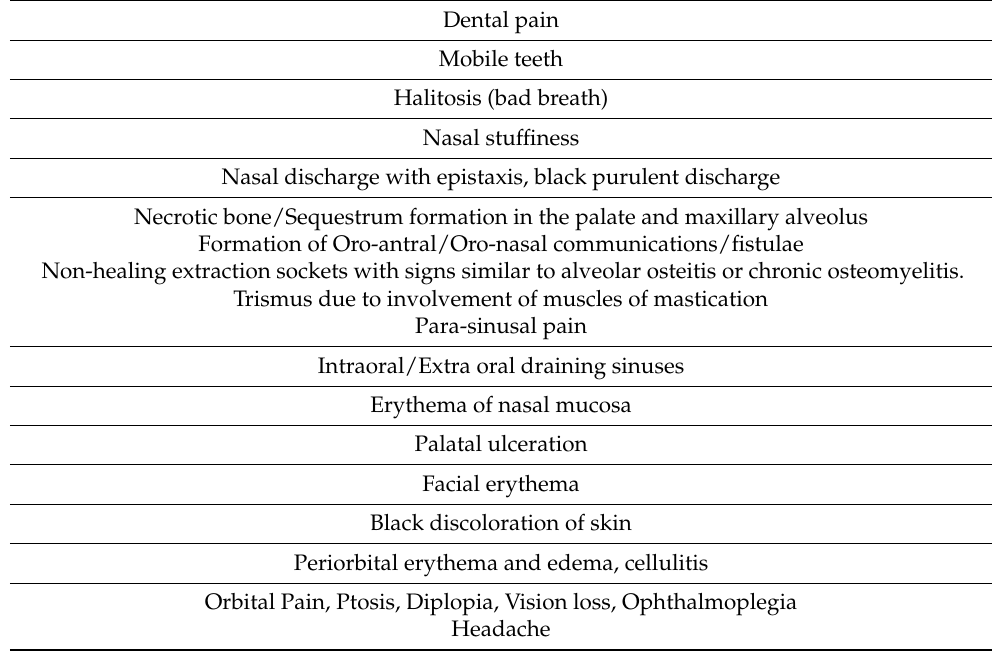
Table 3. Oral and dental manifestations of rhino-orbital-cerebral mucormycosis